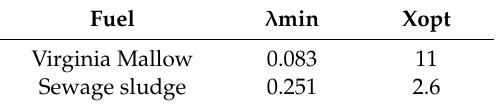
Table 3. λ min and X opt values for Virginia Mallow and sewage